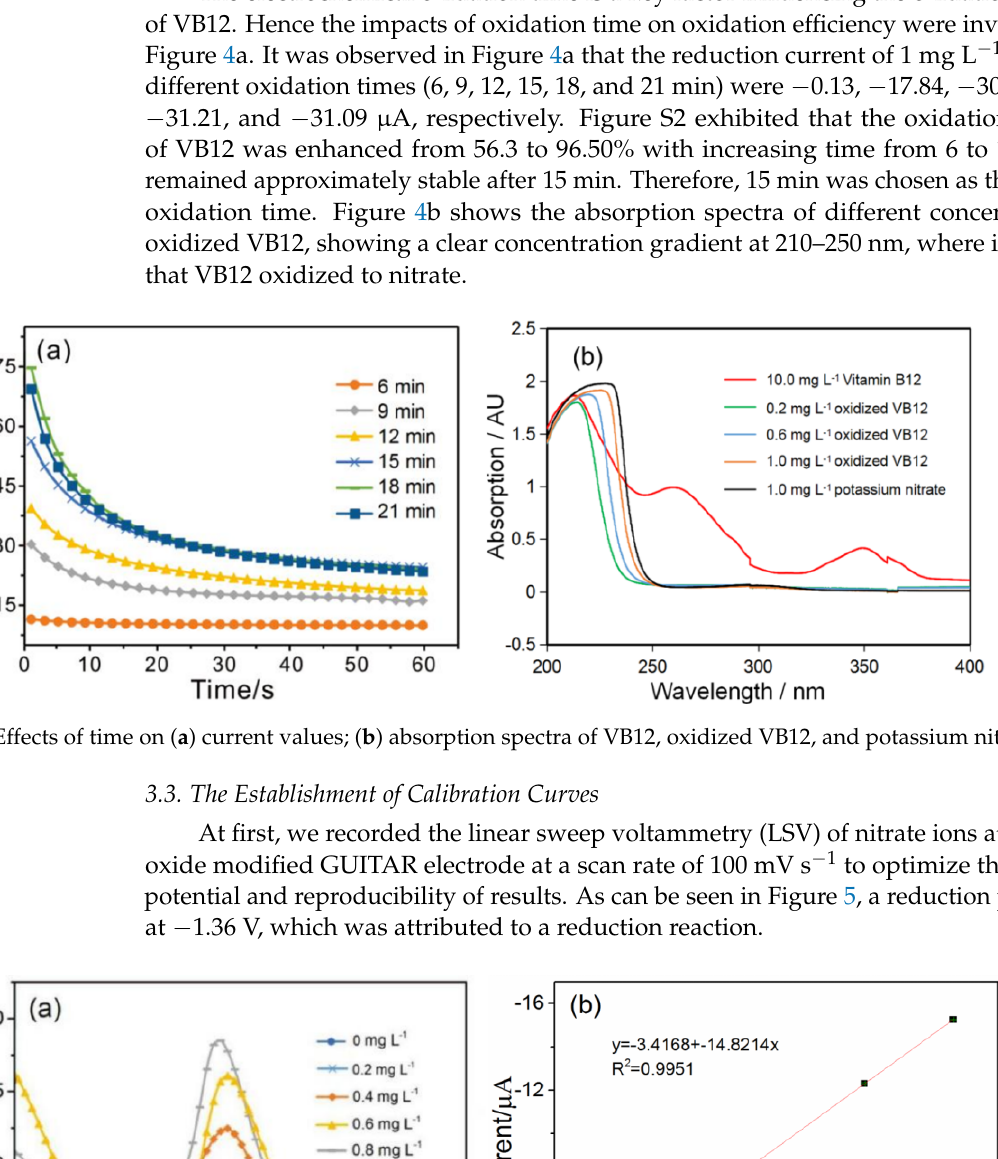
Figure 3. The electrochemical oxidation pathway of VB12.